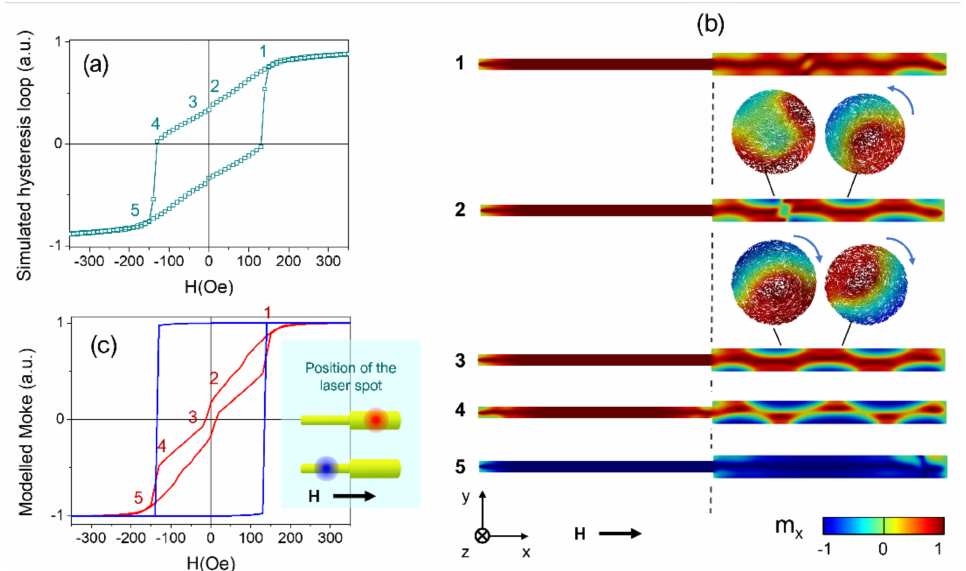
Figure 6. Simulated hysteresis loops of an individual bimodulated Fe 67 Co 33 nanowire ( a ) and longi- tudinal cross-sections of the magnetic configurations in the nanowire at the magnetic states labelled from 1 to 5 ( b ). Transverse cross-sections in the nanowire are shown at selected positions. The arrows indicate the circulation (chirality) of the magnetization. Modelled MOKE signal ( c ) from the micro- magnetic simulations for the two positions of the laser spot in each respective nanowire